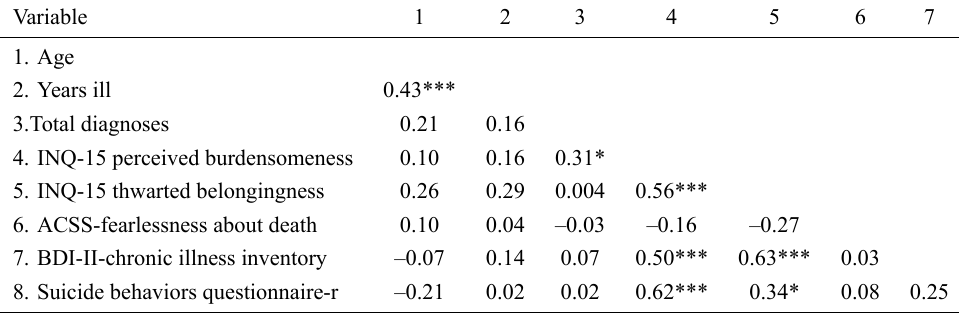
Table 3. Bivariate correlations between all variables (n = 41).